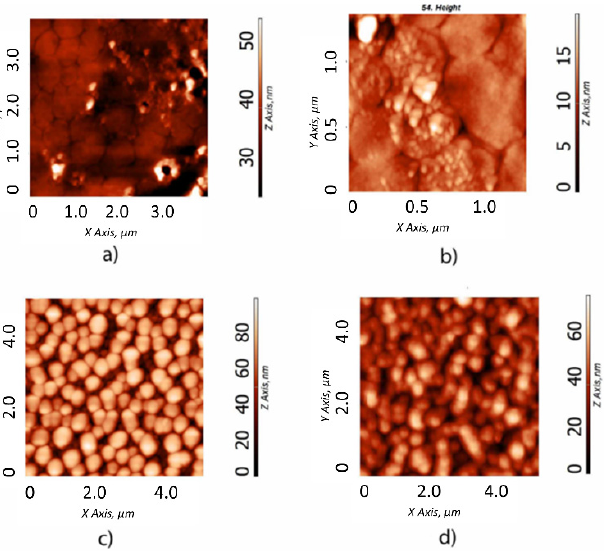
Figure 6. AFM images of the surface morphology of ( a , b ) PC 71 BM:PTB7 ‐ b ‐ P4VP (1.1:1) blend WPNPs film leading to device 1 (RMS: ( a ) 2.3 nm and ( b ) 1.6 nm); ( c ) PC 71 BM:PTB7 ‐ b ‐ P4VP (1.5:1) blend film in chlorobenzene leading to device 2 (RMS: 18.8 nm); and ( d ) commercial PC 71 BM:PTB7 (1.5:1) blend film deposited from chlorobenzene (reference) (RMS: 11.5 nm).